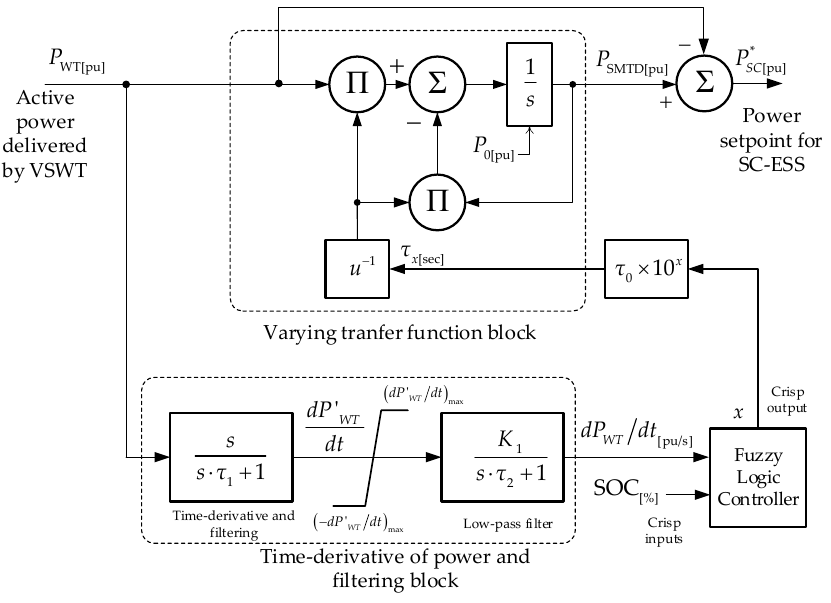
Figure 4. Overall diagram of the proposed controller.